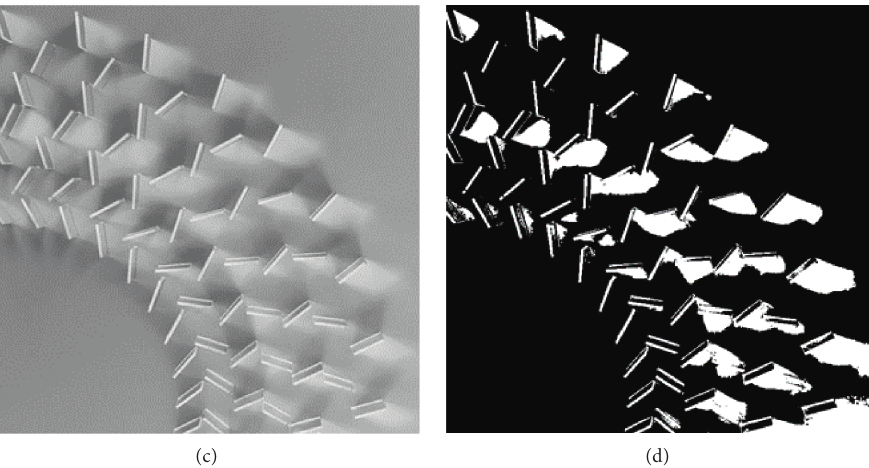
Figure 7: Different order fractional differential processing image. (a) 0.3-order fractional differential. (b) 0.5-order fractional differential. (c) 0.7-order fractional differential. (d) 0.8-order fractional